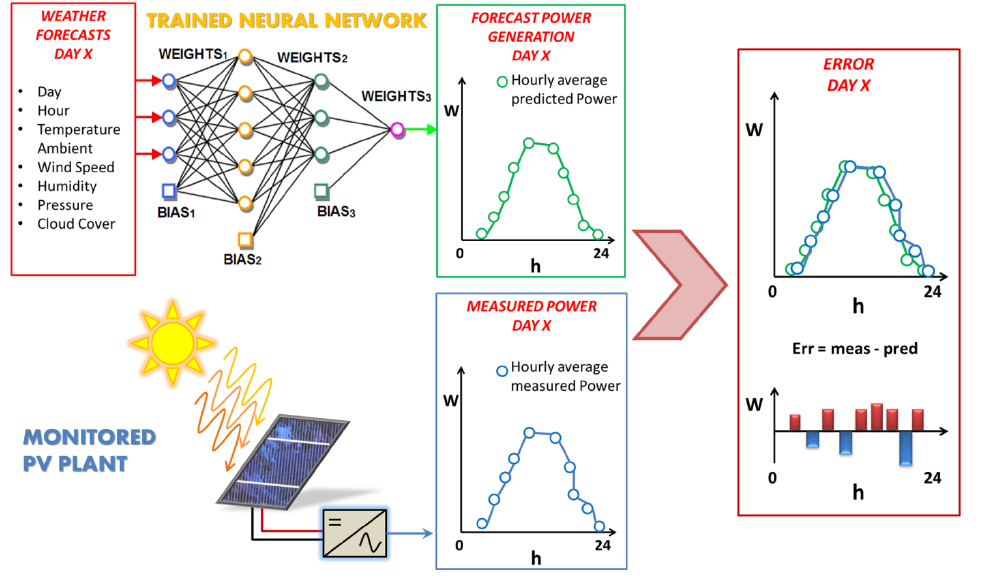
Figure 2. Simplified view of the implemented feed-forward ANN with details on input, output, and hidden